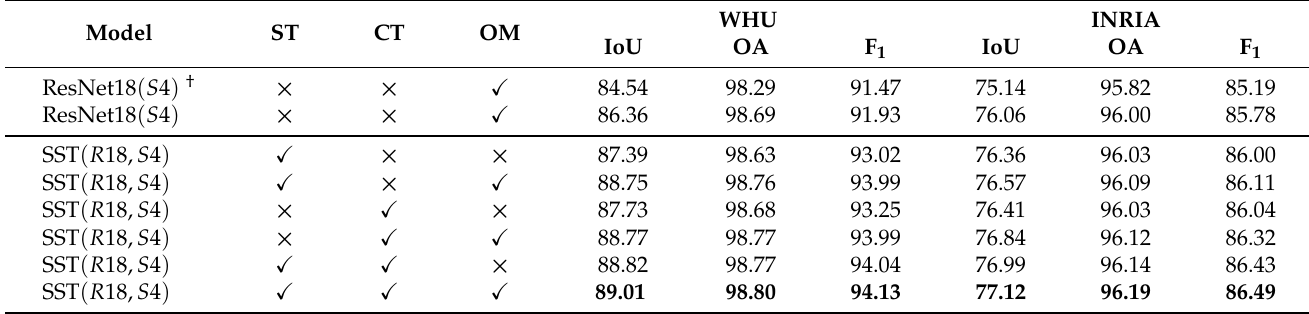
Table 4. Ablation study of the context composing. We conduct experiments on different feature compositions before the final prediction head. ST: Spatial Transformer output, Z ∗ s . CT: Channel Transformer output, Z ∗ c . OM: Original feature Map before the transformer, X . †: Without auxiliary loss to generate probabilistic maps.